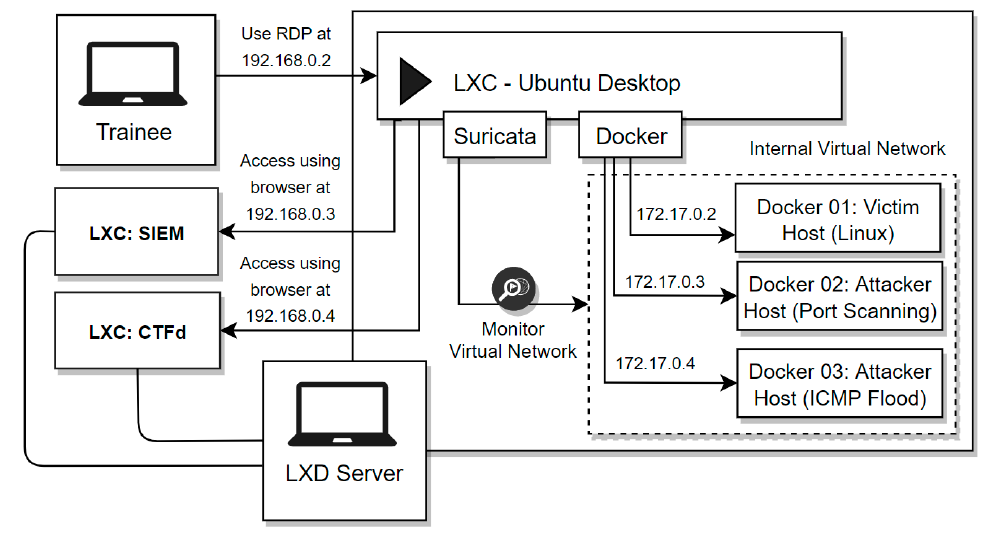
Figure 2. Proof of concept deployment of PocketCTF.